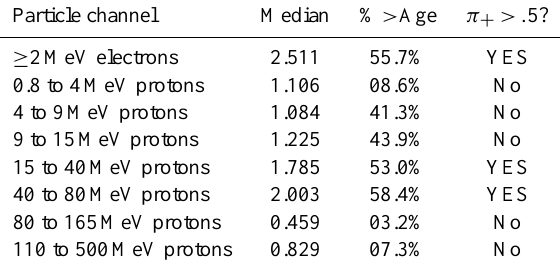
Table 1. Analysis of perceived age distributions. The left col- umn lists the eight GOES EPS particle/energy channels used in this study. The second column lists the medians of each distribution. The third column shows the percent of anomalies of all analyzed where the perceived age was greater than the actual age at the time of the anomaly. Finally, the right-most column reports if the sam- ple represents a parent population where greater than 50% of all anomalies have perceived ages greater than the actual ages (99% confidence